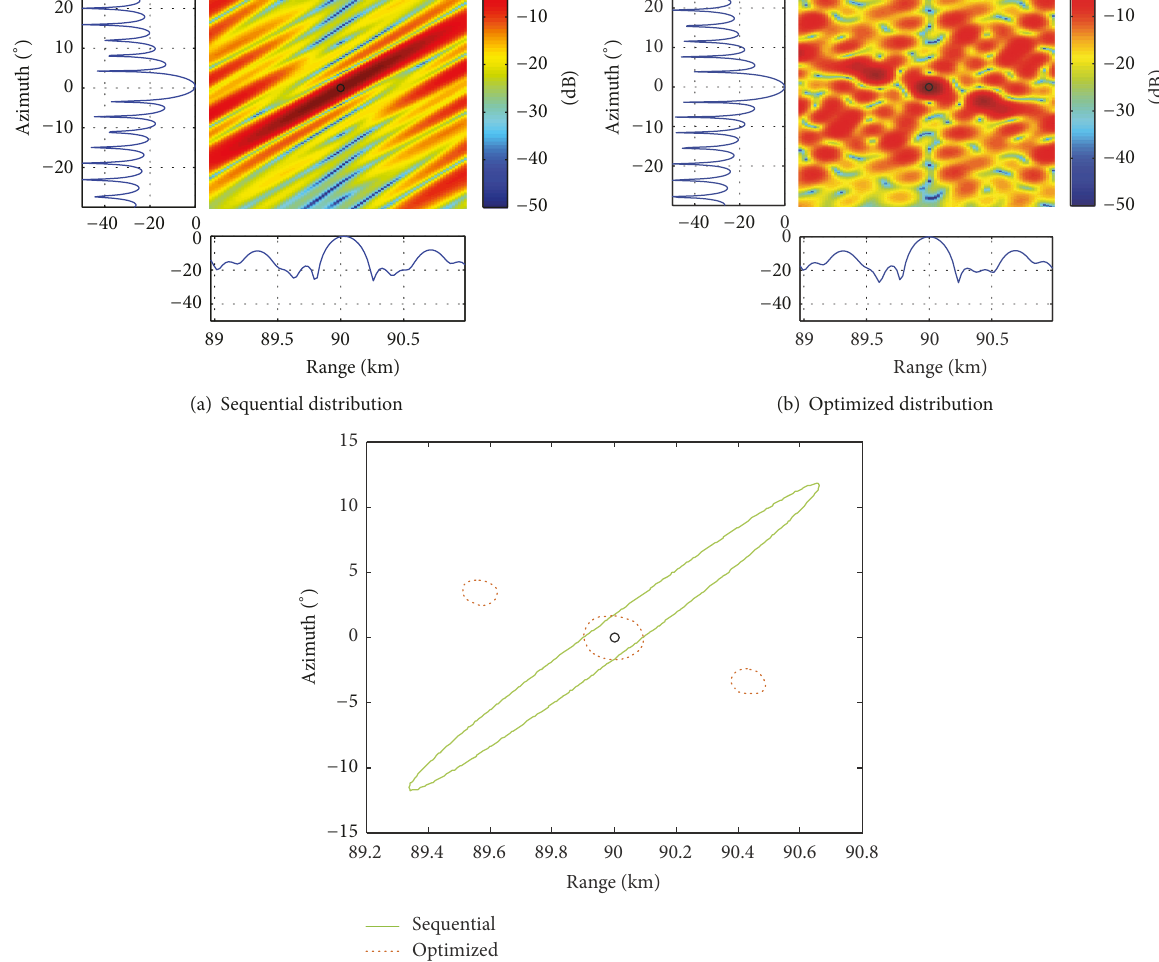
−15−10−5 (c) Plots of the − 3dB isolines Figure 7: Ambiguity functions of the transmit waveforms when using sequential carrier frequency distribution and optimized carrier frequency